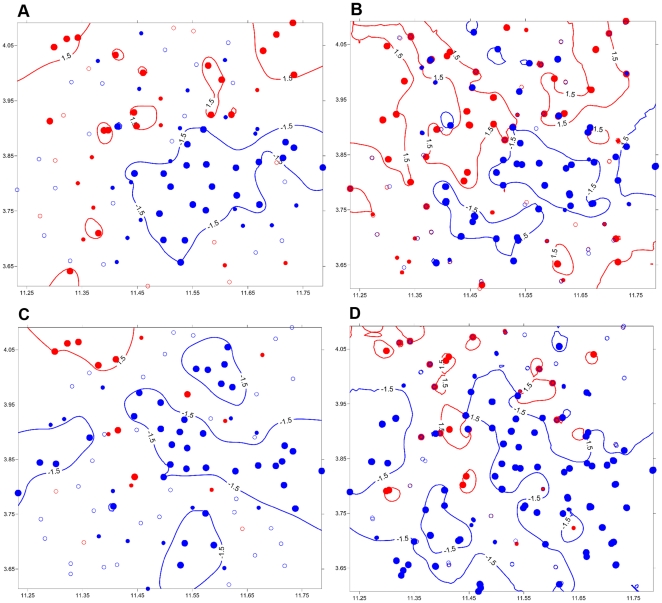
Maps of SADIE clustering indices.
An. gambiae: (A) locality level and (B) house level. An. funestus: (C) locality level and (D) house level. Each sample unit is characterized by a positive (red circles) or a negative (blue circles) clustering index. Small open circles: absolute value of clustering below expectation (1); small filled circles: sample units with clustering that exceeds expectation (<−1 or >1); large filled circles: sample unit with high clustering indices (<−1.5 or >1.5).